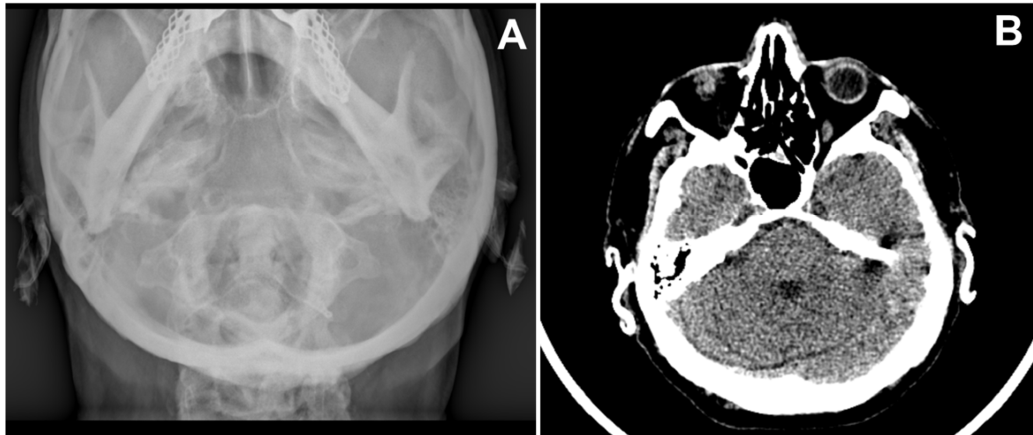
Figure 2. ( A ) X-ray of the skull showing opacification of both helices; ( B ) Computerized tomography of skull reveals calcification of right and left pinna.